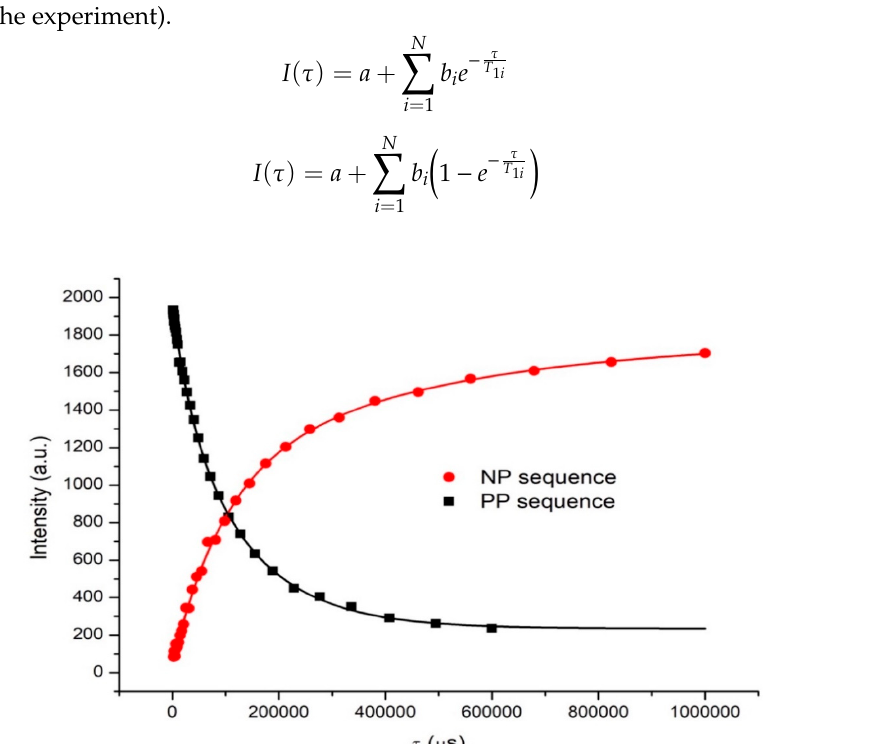
Figure 3. Decay and recovery curves obtained by applying the pre-polarized (PP) and non-polarized (NP) sequences, respectively. The dots are the data points collected by analyzing a sample of quartz sand (1 g) filled with Milli-Q grade water (3 mL). The PP sequence was applied at a relaxation field ( B RLX ) proton Larmor frequency of 0.1 MHz, while the B RLX proton Larmor frequency for the NP sequence was 30 MHz. The full lines are the fitting curves obtained by applying the biexponential form of Equations (2) and (3) for the PP and NP sequence, respectively (unpublished results).